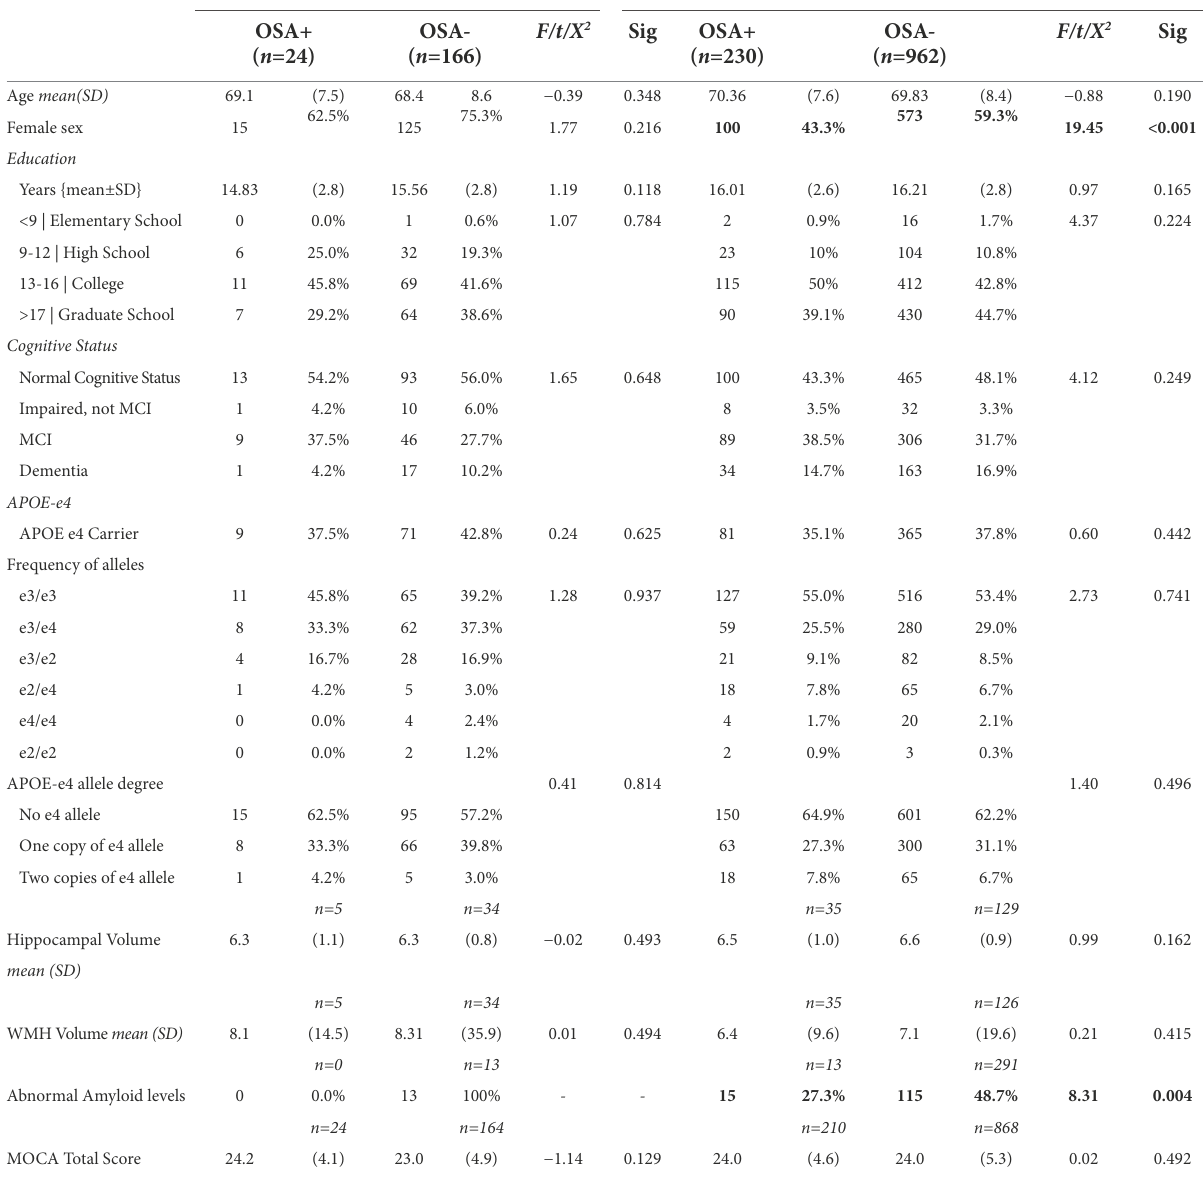
TABLE 2 Sample characteristics by OSA status and